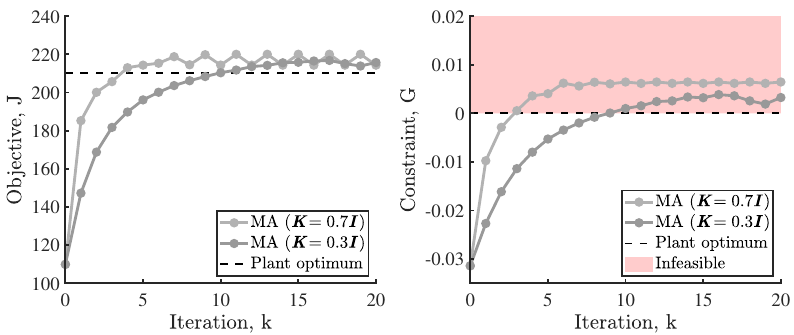
Figure 4. WO case study using the standard MA approach using a high gain and a low gain, both producing unstable solutions.